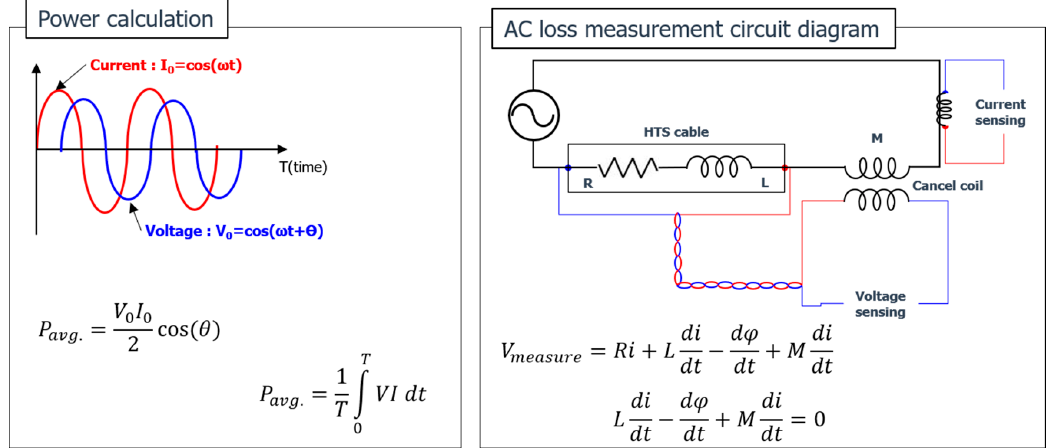
Figure 12. Principle of AC loss measurement.